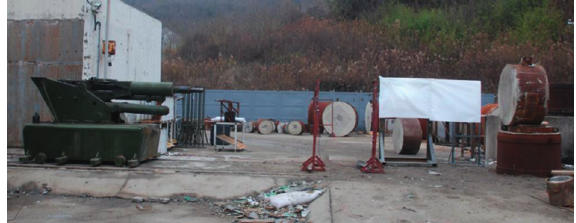
Figure 5: Penetration experiment site.